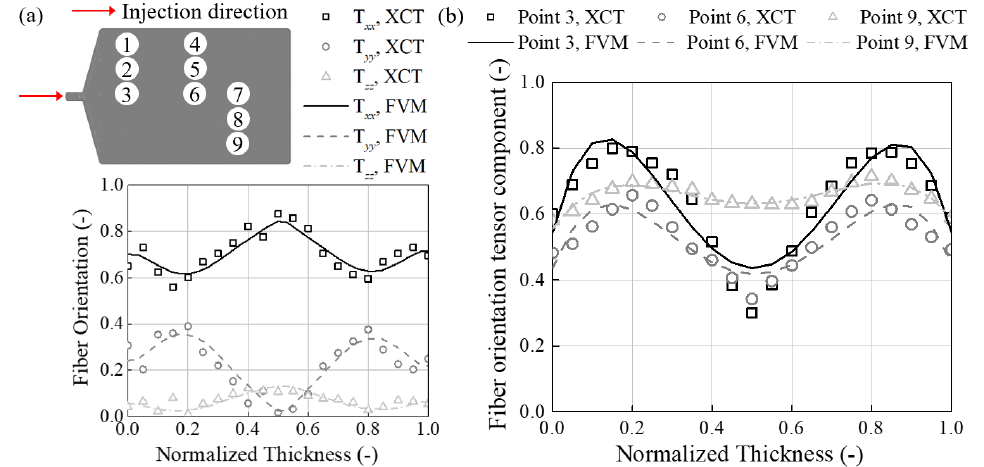
Figure 11. ( a ) The analysis points on the injection molded plate and the fiber orientation vectors on point 7. ( b ) The fiber orientation tensor component results on points 3, 6, and 9.